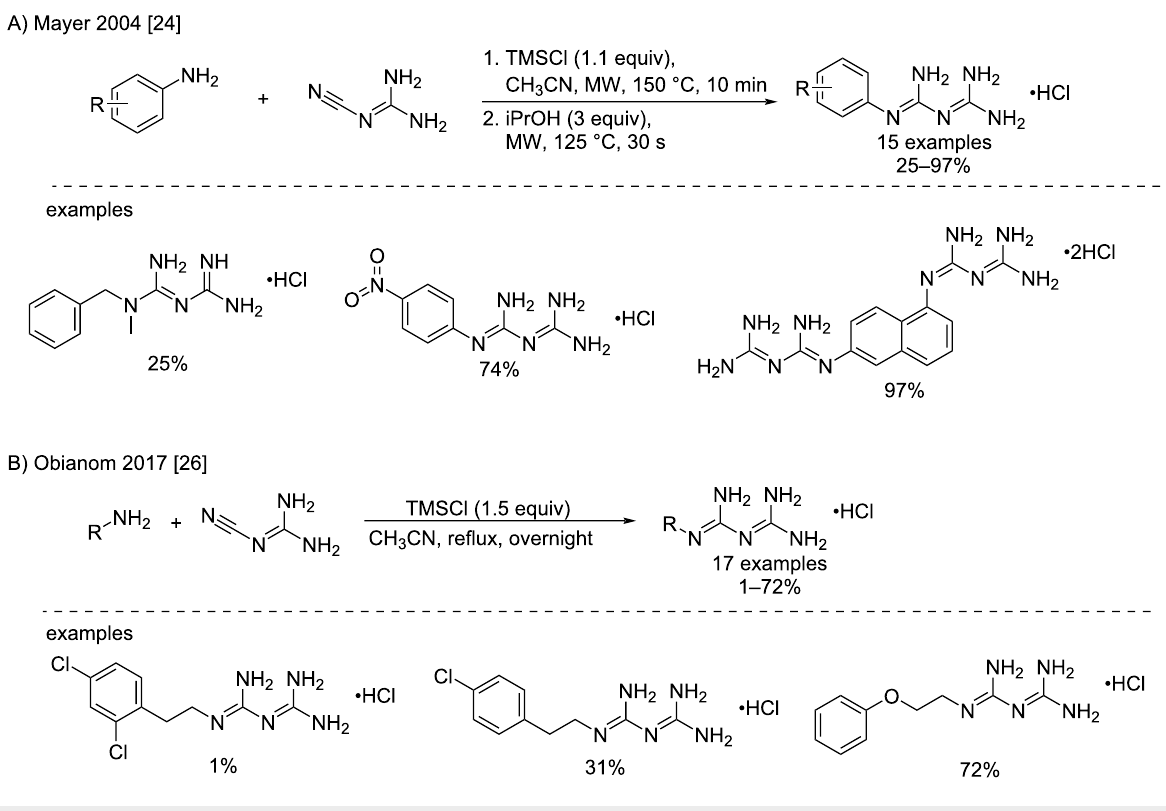
Scheme 8: Synthesis of aryl- and alkylbiguanides by trimethylsilyl activation